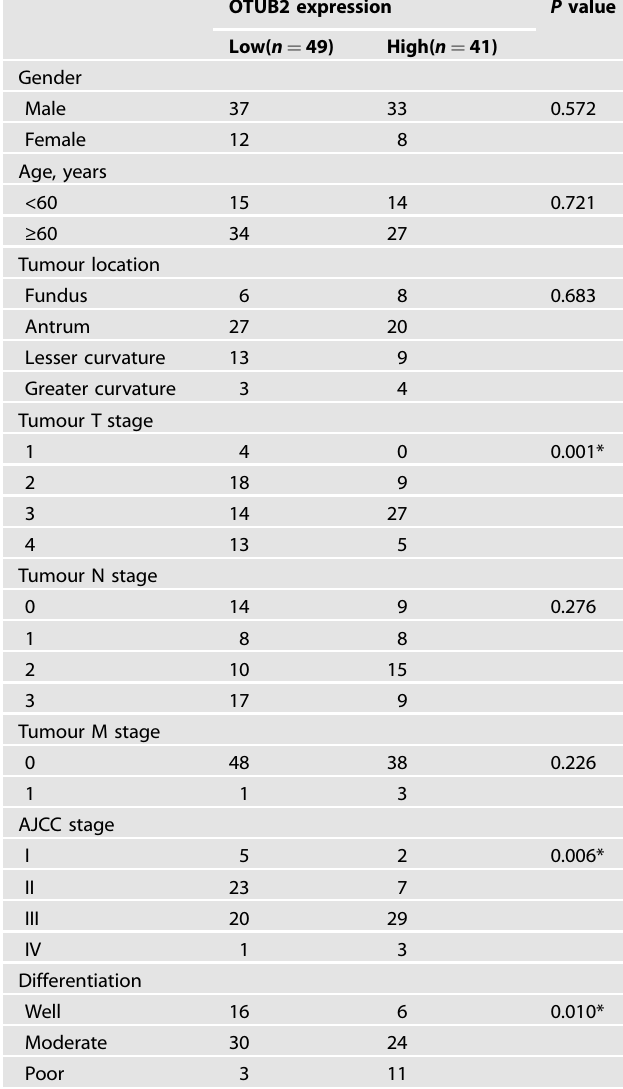
Table 1. Association between clinicopathological parameters and OTUB2 expression ( n =